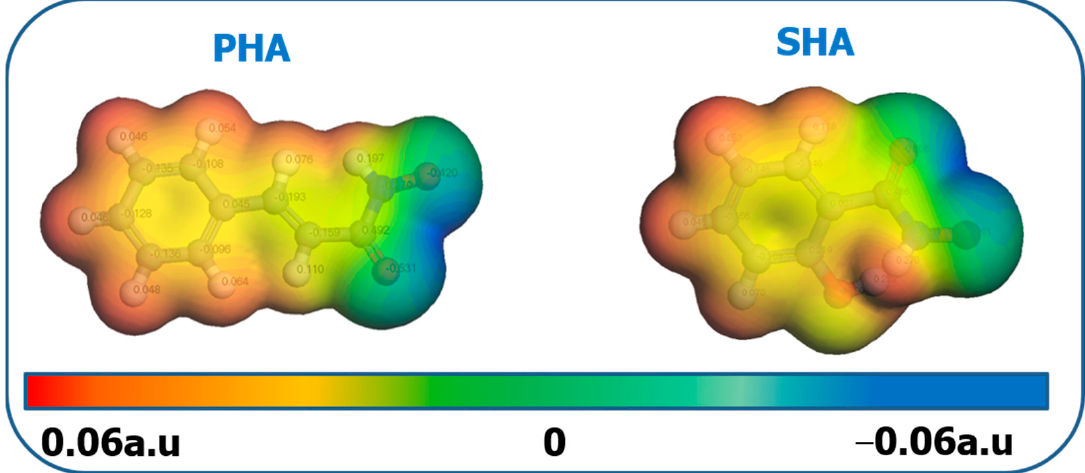
Figure 9. MEP map of PHA and